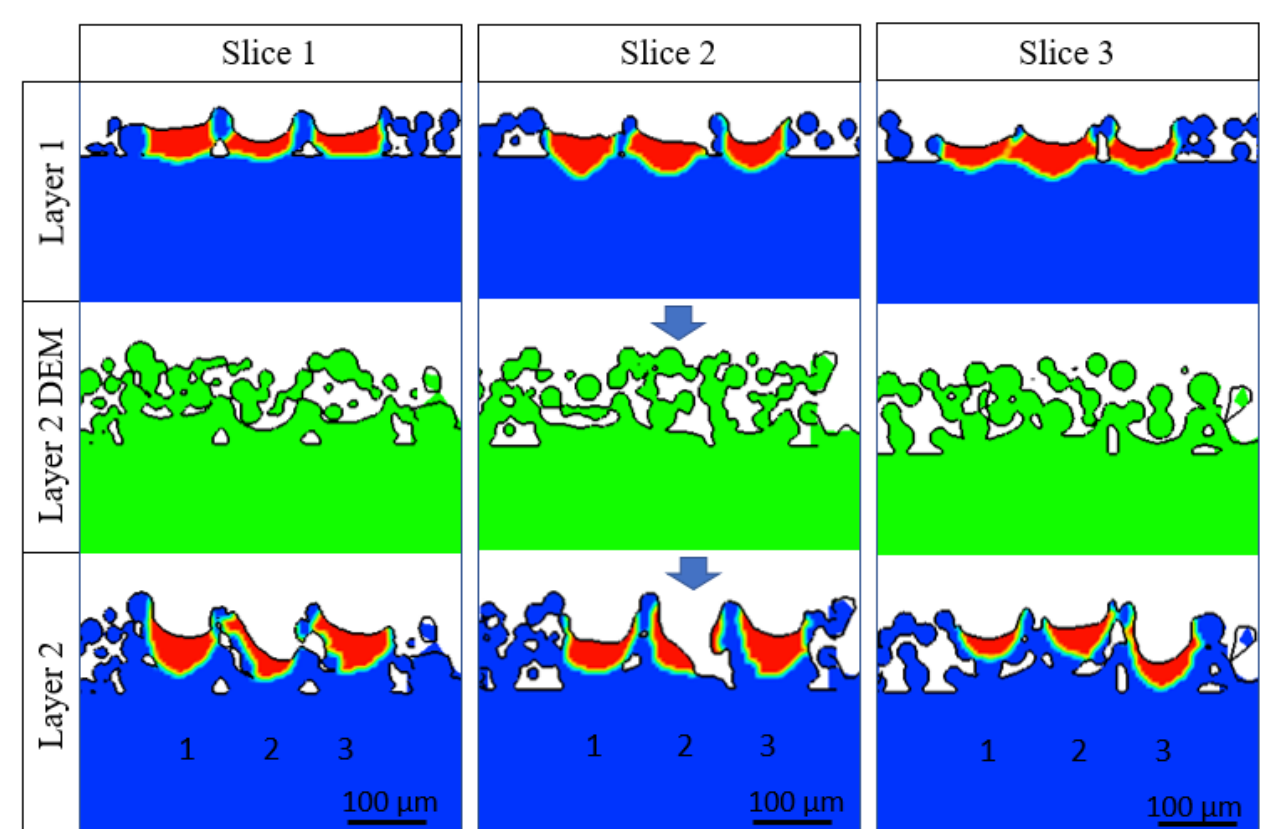
Figure 18. Second layer melt pool boundary obtained with 195 W laser power, 1500 mm/s scan speed, 120 µm hatch spacing and 0.5 mm scan length.